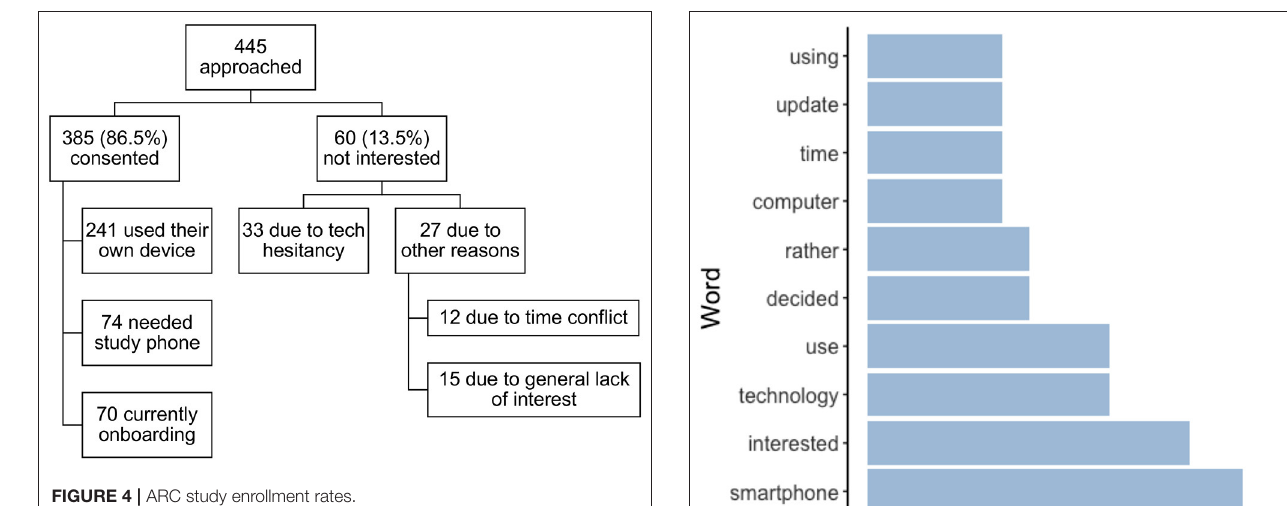
TABLE 2 | Individuals who declined ARC participation.